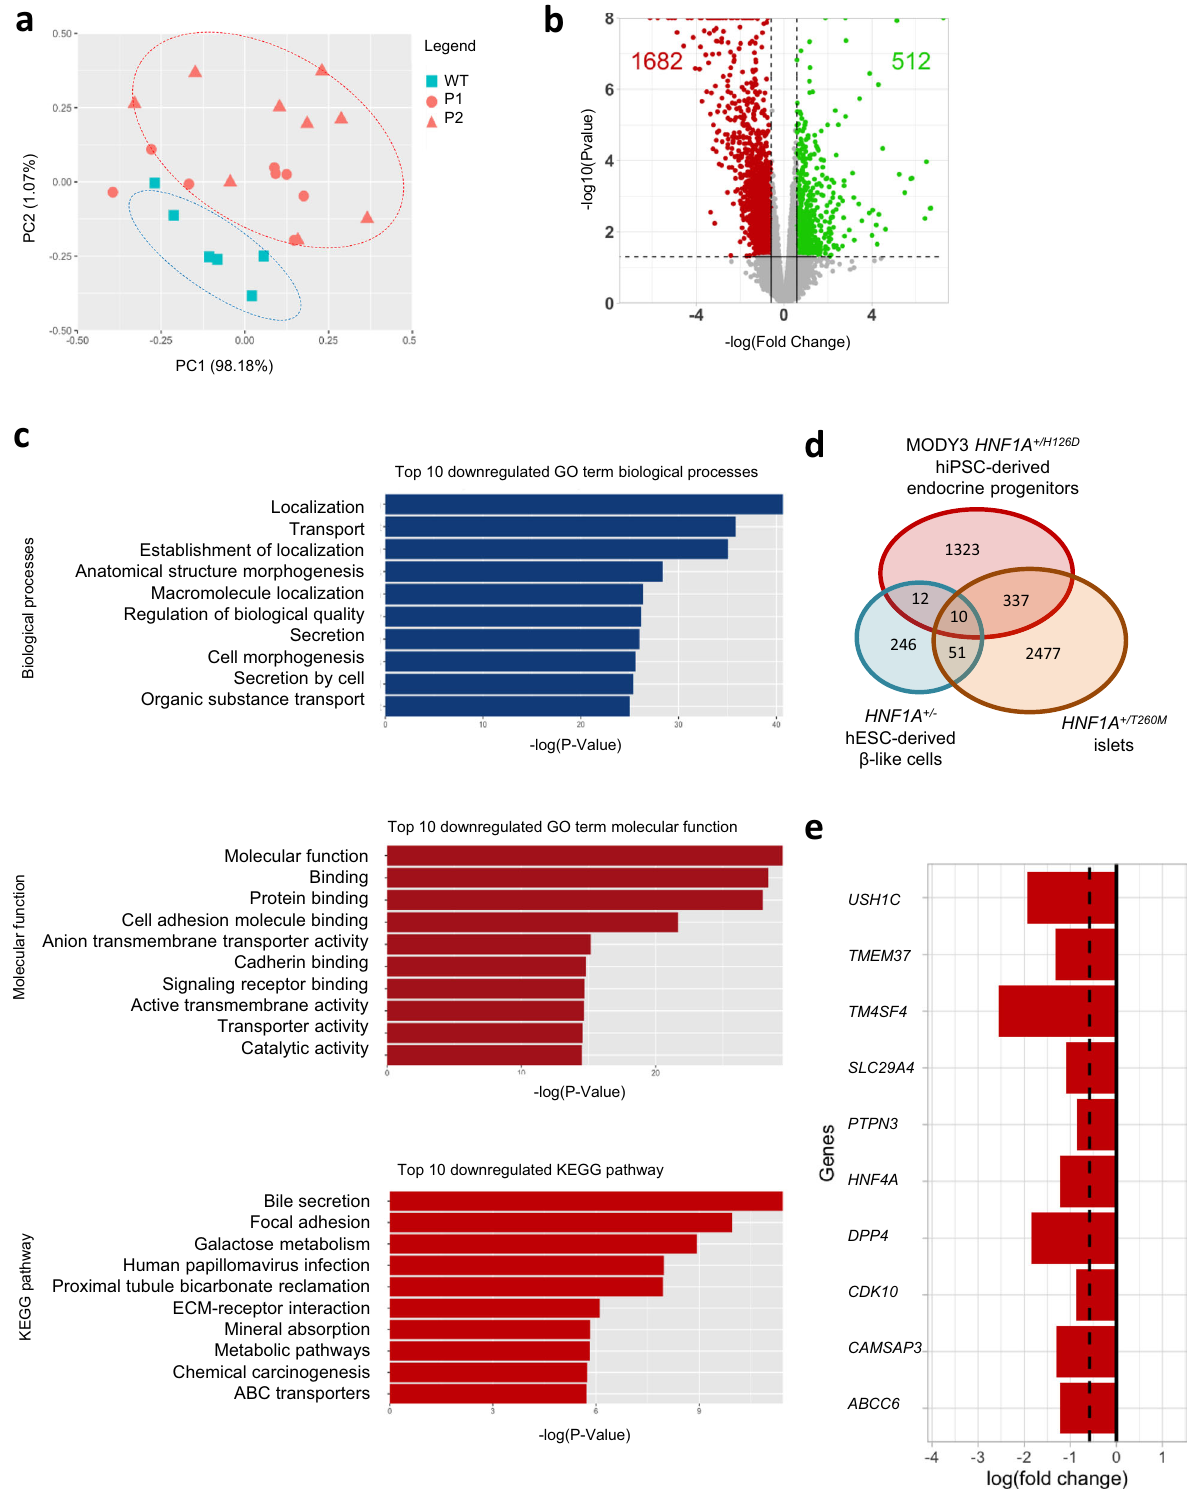
than GLUT2, as the principal glucose transporters in human pancreatic β cells 44 . Immunostaining analyses further con fi rmed the decrease in GLUT2 protein expression in mutant pancreatic cells (Fig. 7d). We further con fi rmed the co-expression of HNF1A and GLUT2 with INS in the INS + β -like cells (Fig. S9). To ascertain the function of GLUT2 in glucose uptake in human β cells, we used a GLUT2 inhibitor, fi setin 45 , to